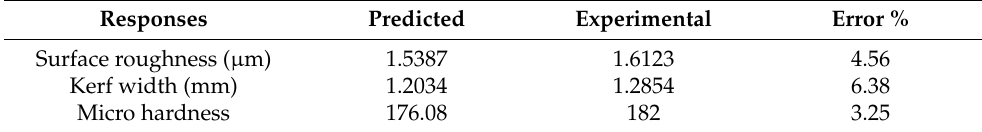
Table 9. Validation results for Ra , kw , and mh